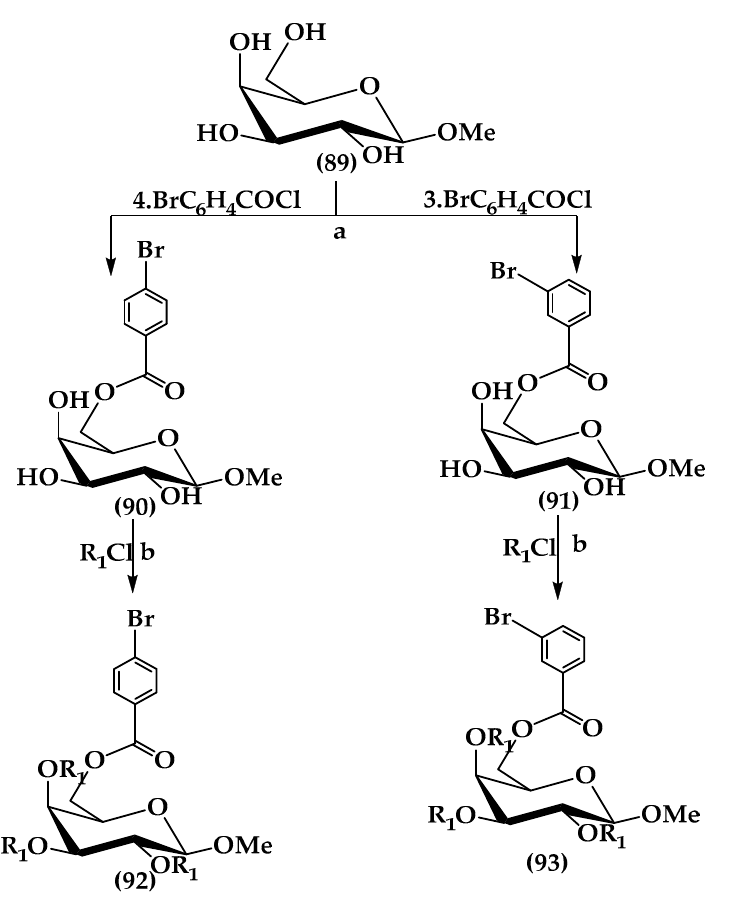
Scheme 4. Synthesis of methyl β - D -galactopyranoside ( β -MGP) derivatives. Reagents and